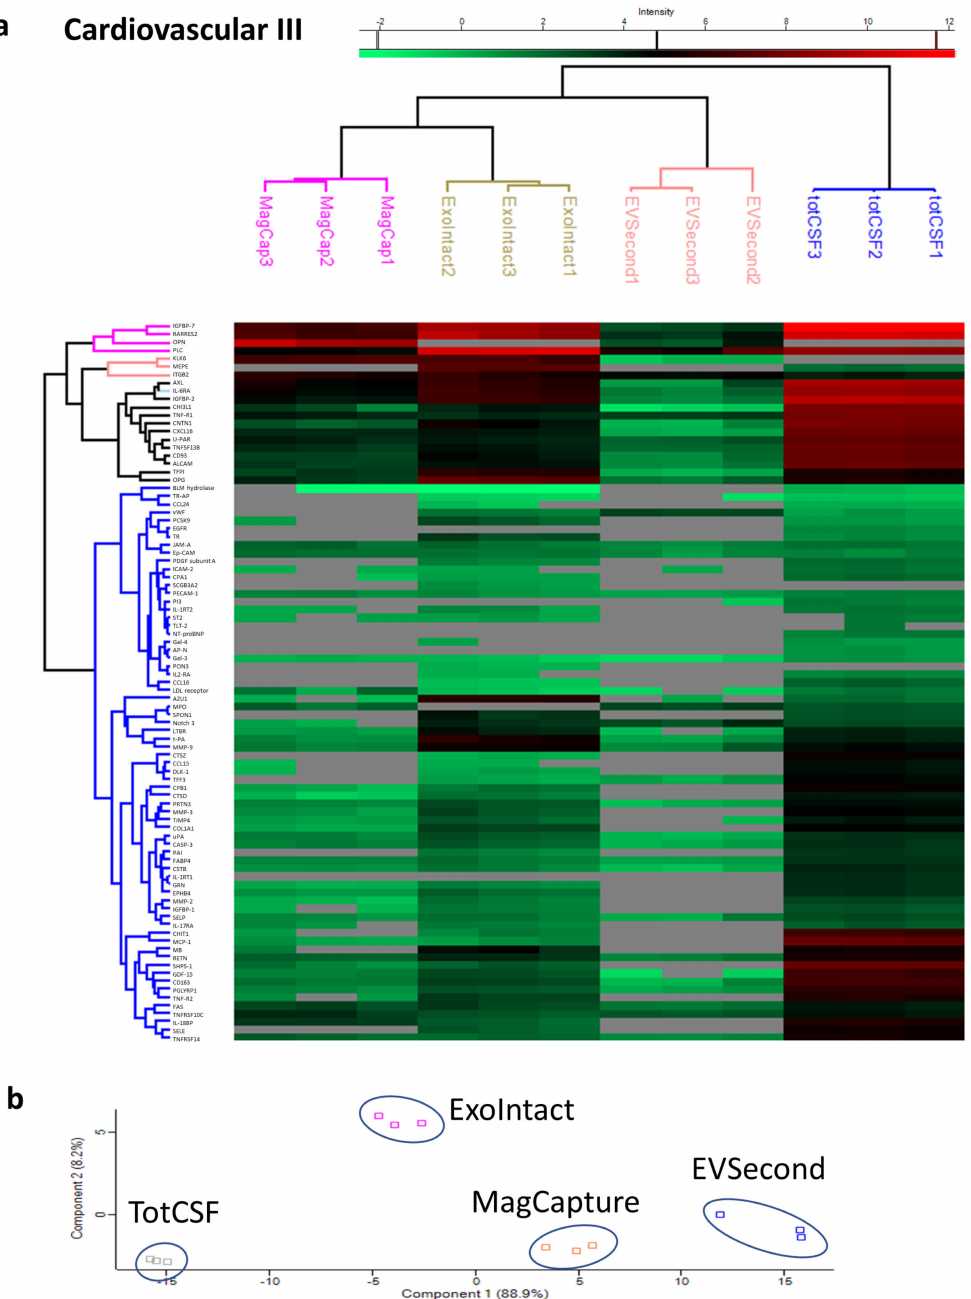
Figure 5. Hierarchical clustering and principal component analysis of data from the cardiovascular III panel. ( a ) Hierarchical clustering where each column represents a sample, and each row represents an analyte. The color of each cell represents intensity, as indicated by the color gradient on the top of the image; gray color indicates a missing value. ( b ) The principal component analysis (PCA) plot represents 31 proteins that were detected in all samples, showing clear clustering of samples from the di ff erent groups. Tot CSF: total CSF, MagCap: